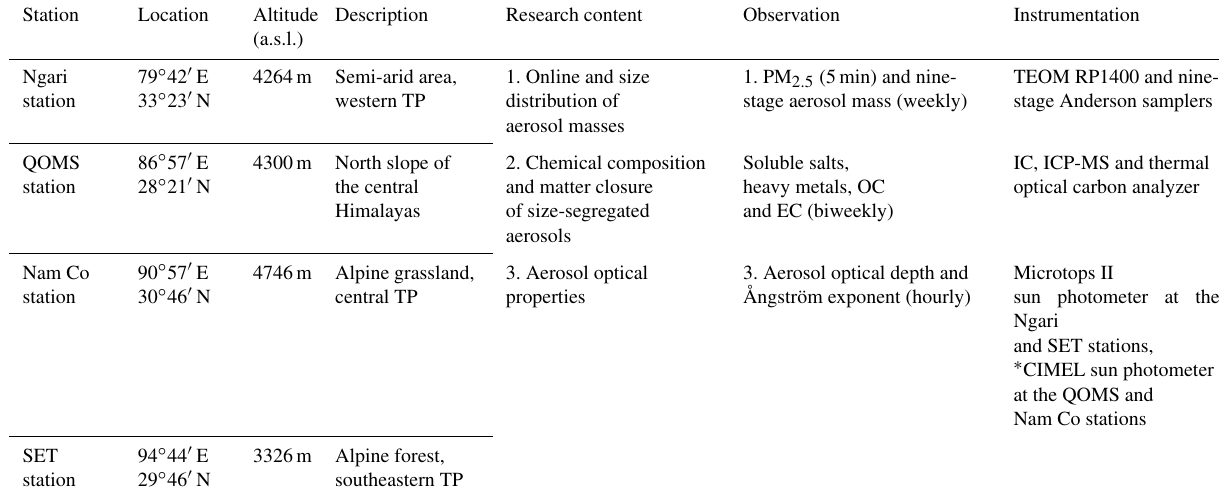
Table 1. Geographical conditions and aerosol observations at HTP background sites (Ngari, QOMS, Nam Co and SET stations). Station Location Altitude